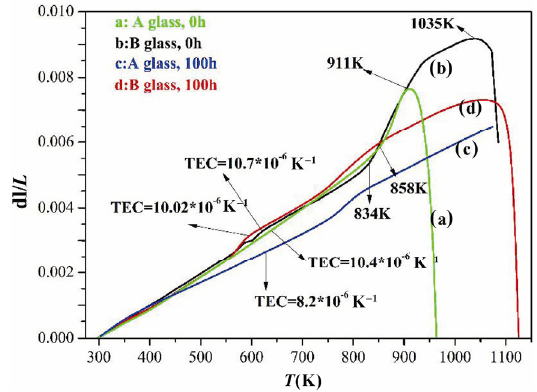
Fig. 7 Thermal expansion curves of glass after different heat treatment: (a) A glass at 1023 K for 0 h; (b) B glass at 1023 K for 0 h; (c) A glass at 1023 K for 100 h; (d) B glass at 1023 K for 100 h.